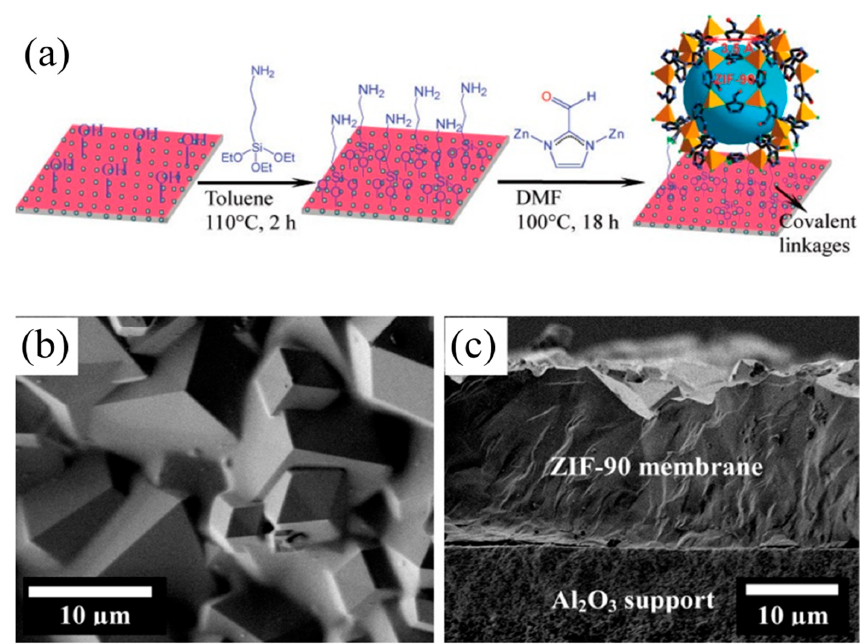
Figure 4. ( a ) Scheme of the preparation of ZIF-90 membrane via imine condensation reaction with 3-aminopropyltriethoxysilane (APTES) as a covalent linker; SEM images of ( b ) a top view and ( c ) a cross section of the resulted ZIF-90 membrane. Reprinted with permission from Reference [56]. Copyright 2010 the American Chemical Society, (Washington, DC, USA).